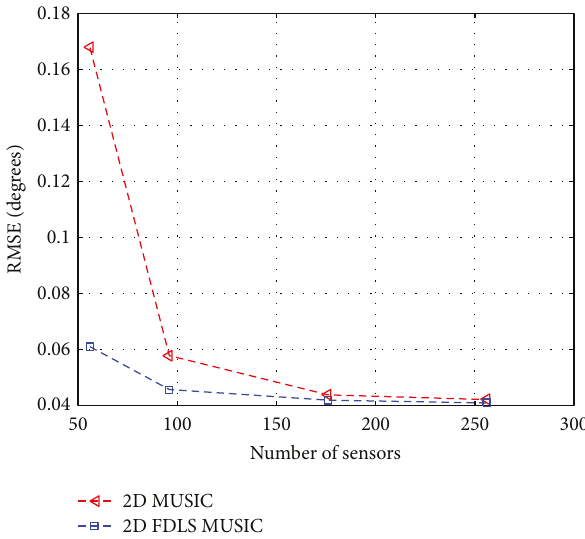
Figure 4: RMSE comparison between 2D MUSIC and 2D FDLS versus sensor number.